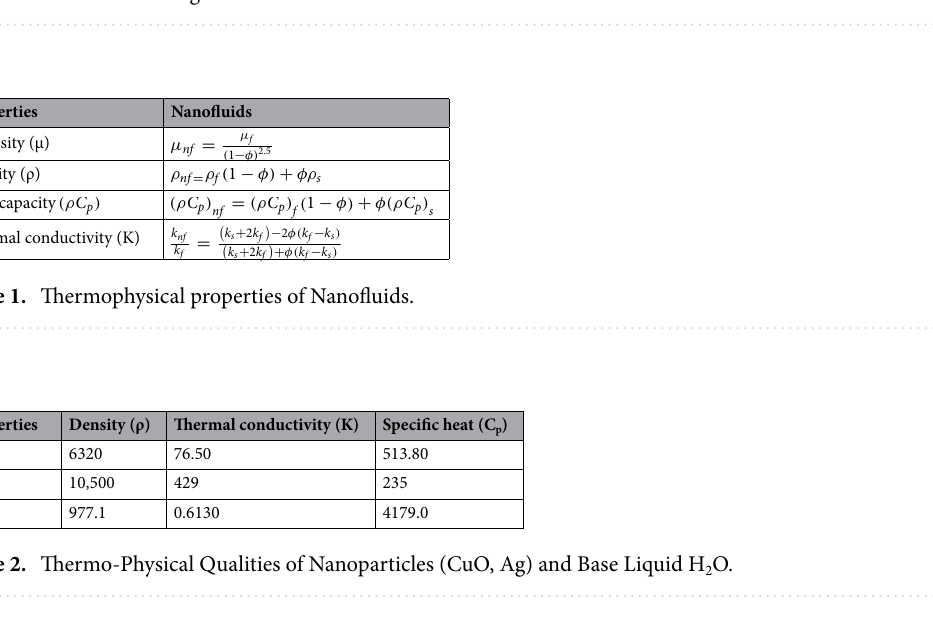
Figure 10. ( a ) Outcome of α and φ over Nusselt number for CuO-water of nanofluid. ( b ) Outcome of α and φ over Nusselt number for Ag-water of nanofluid.